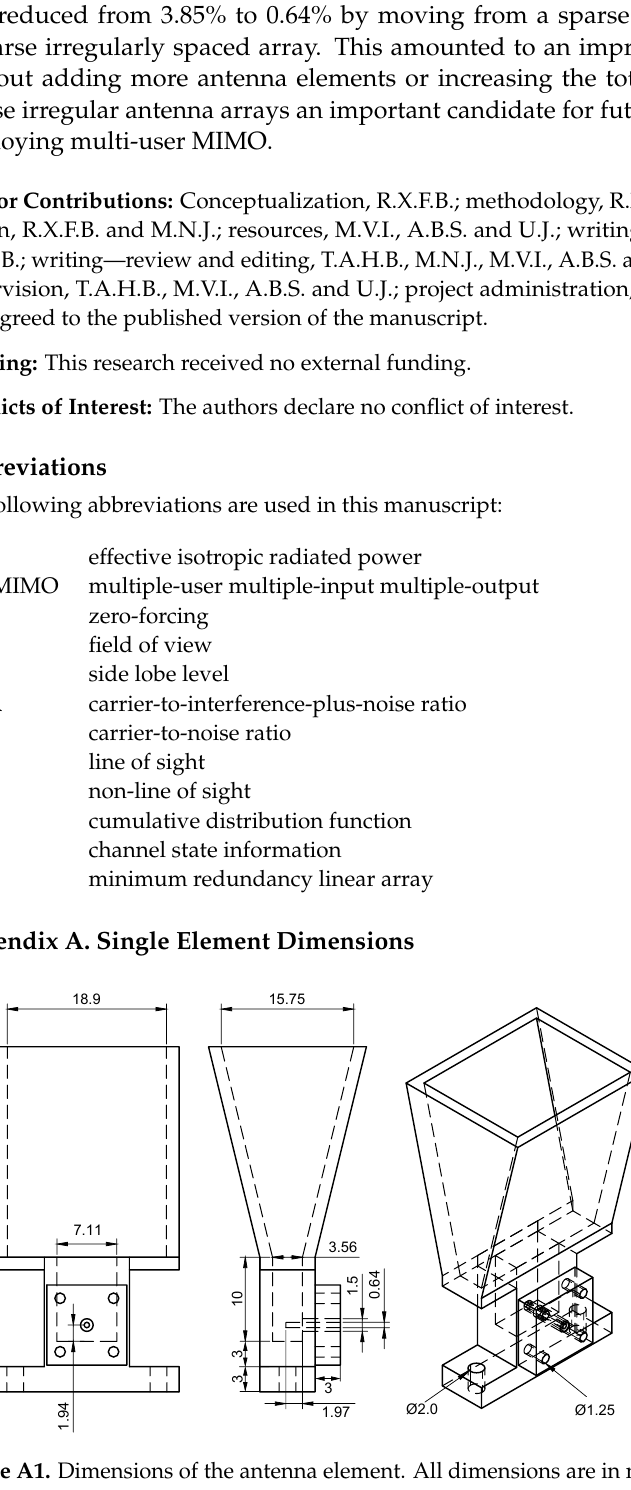
Figure A1. Dimensions of the antenna element. All dimensions are in mm. The thickness of the walls is 1.5 mm; the distance between the holes for the connector screws is 6.35 mm, in a square pattern with the hole for the pin in the